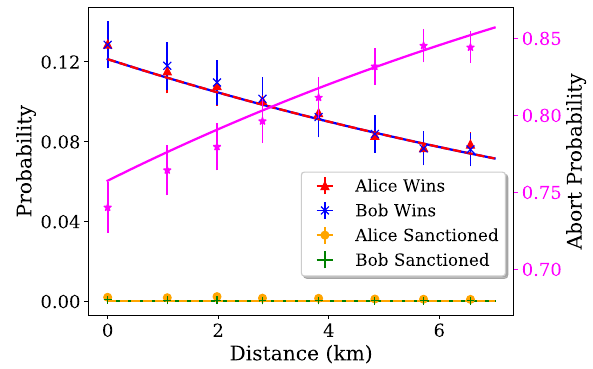
Fig. 3 | Probability of each outcome of the protocol, measured for different communication distances between Alice and Bob. The abort probability is shownontherightaxis,inmagenta.Thelinesrepresentthetheoreticalevolutionof probabilities, calculated via Eqs. (5) to (10), with ef fi ciencies given in Table 1. The error bars are mainly due to error propagation on these ef fi ciencies.